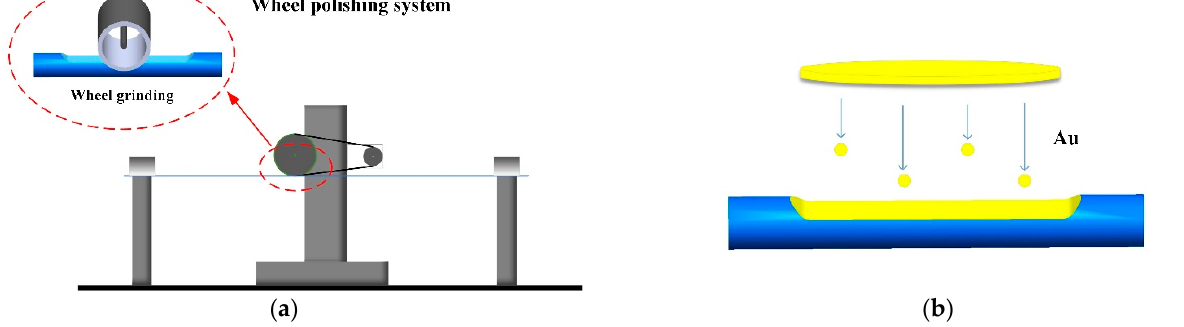
Figure 2. Schematic of the fabrication process for the sensor probe: ( a ) Side-polish process; ( b ) Sputtering process.